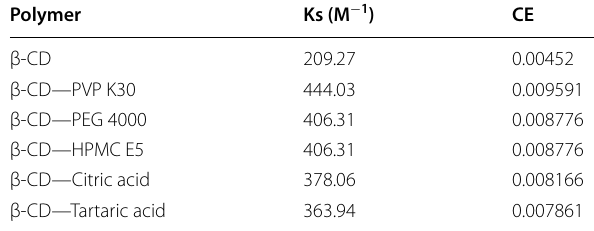
Table 1 The complexation efficiency of β-CD in presence